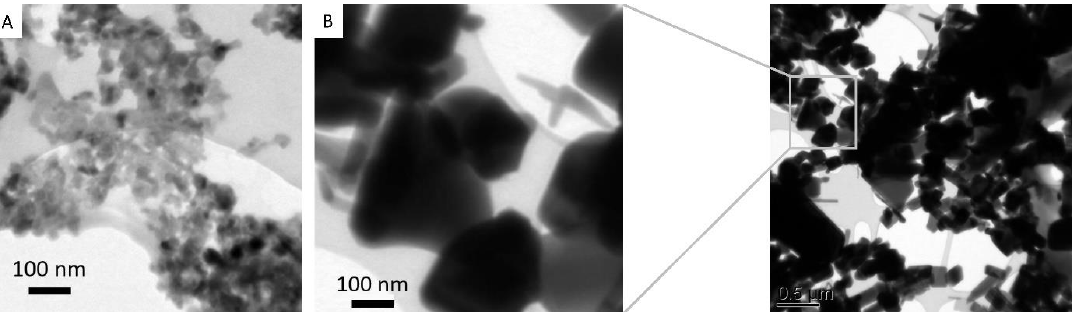
Figure 2. High-resolution transmission electron microscopy images of ZnO ( A ) nanoparticles, ( B ) bulk zincite.